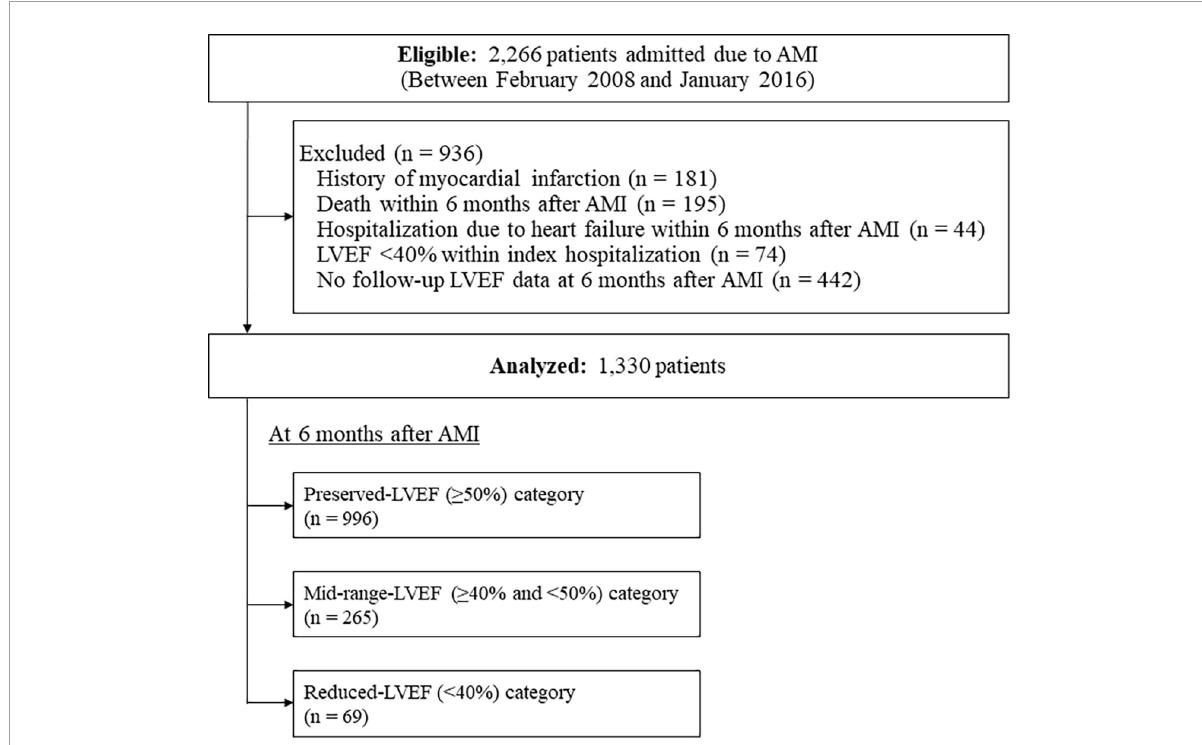
FIGURE1 Flow diagram of the study cohort. AMI, acute myocardial infarction; LVEF, left ventricular ejection